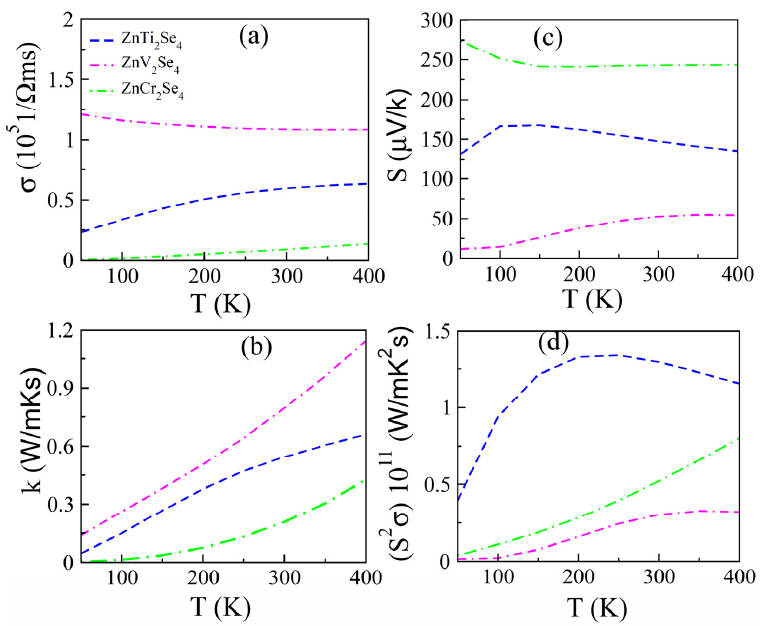
Figure 5. ( a ) σ , ( b ) k , ( c ) S and ( d ) σ S 2 of ZnX 2 Se 4 (X = Ti, V, Cr) computed by Boltz TraP code.